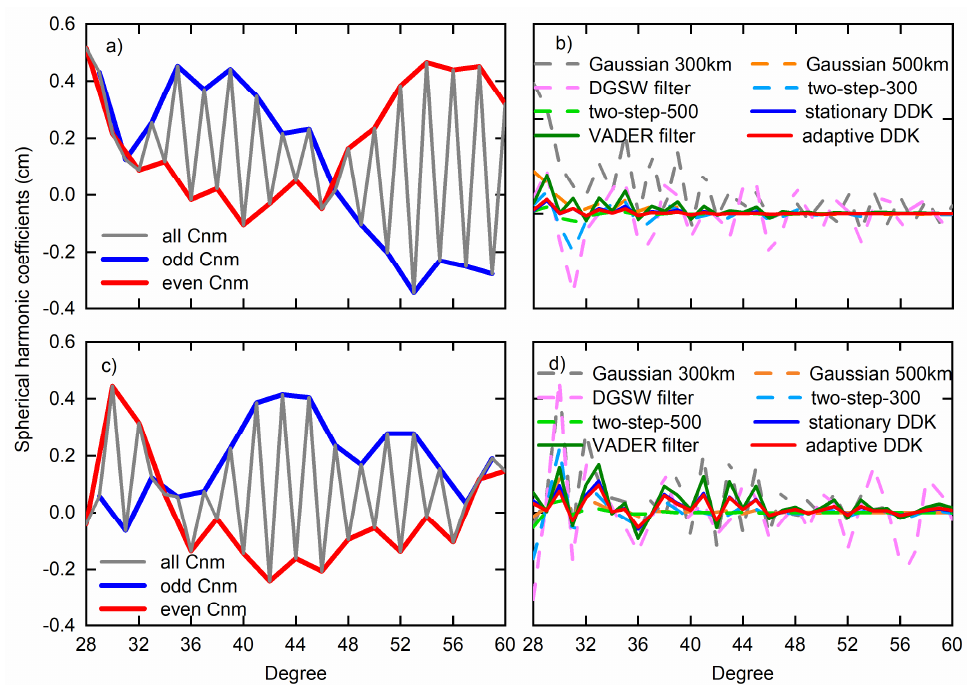
Figure 10. The unfiltered ( a , c ) and filtered ( b , d ) SH coefficient Cnm of the degree n for a specific order m = 28, in September 2006 ( top ) and July 2010 ( bottom ).